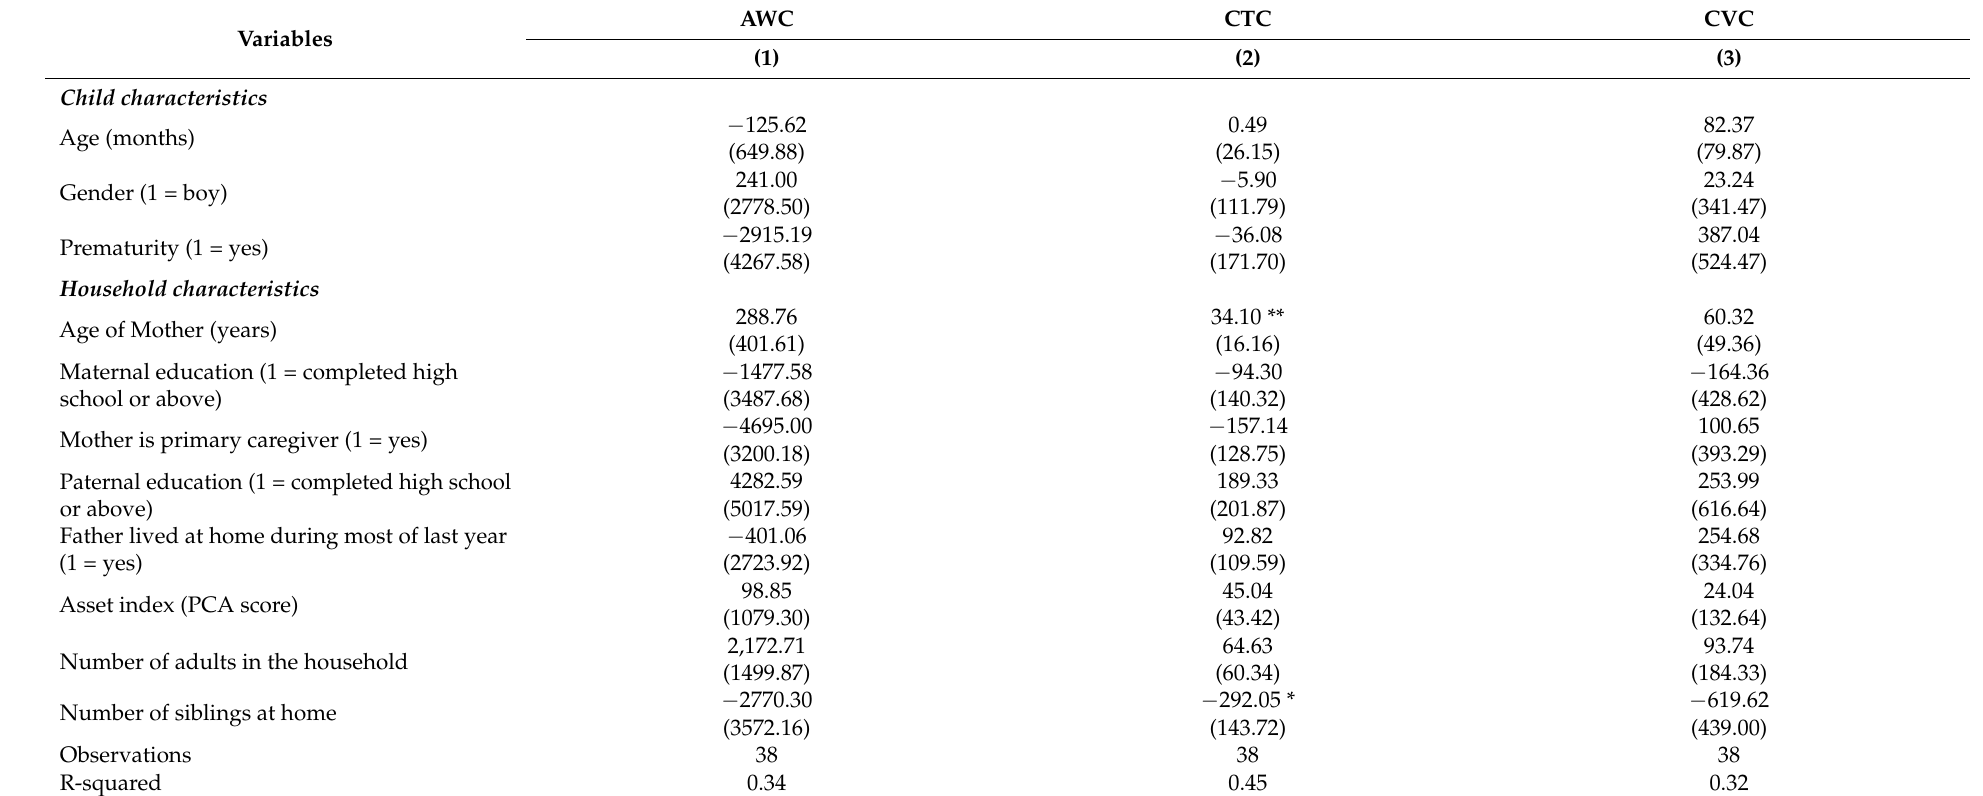
Table 5. Multivariate correlations between household characteristics and AWC, CTC and